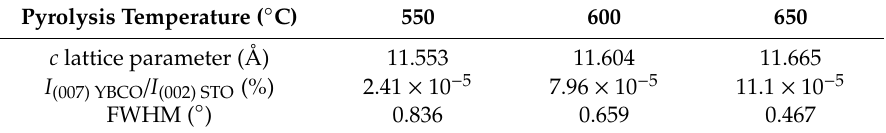
Table 1. Dependence of structural parameters of YBCO films on the pyrolysis